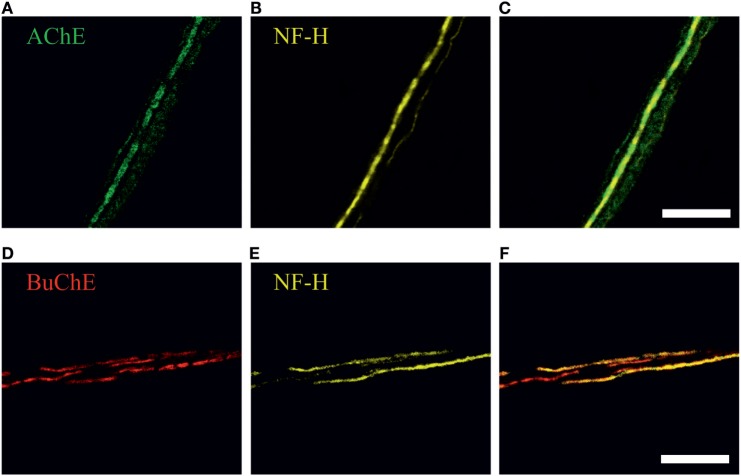
Immunohistochemical staining of (A) acetylcholinesterase (AChE, green), (D) butyrylcholinesterase (BuChE, red) and (B,E) neurofilaments (NF-H, neurofilaments heavy chain, yellow) in perivascular nerve fibers in rat dura mater preparation. Co-localization with neurofilaments, markers of myelinated axons, is shown in (C) and (F). Scale bar, 40 µm.